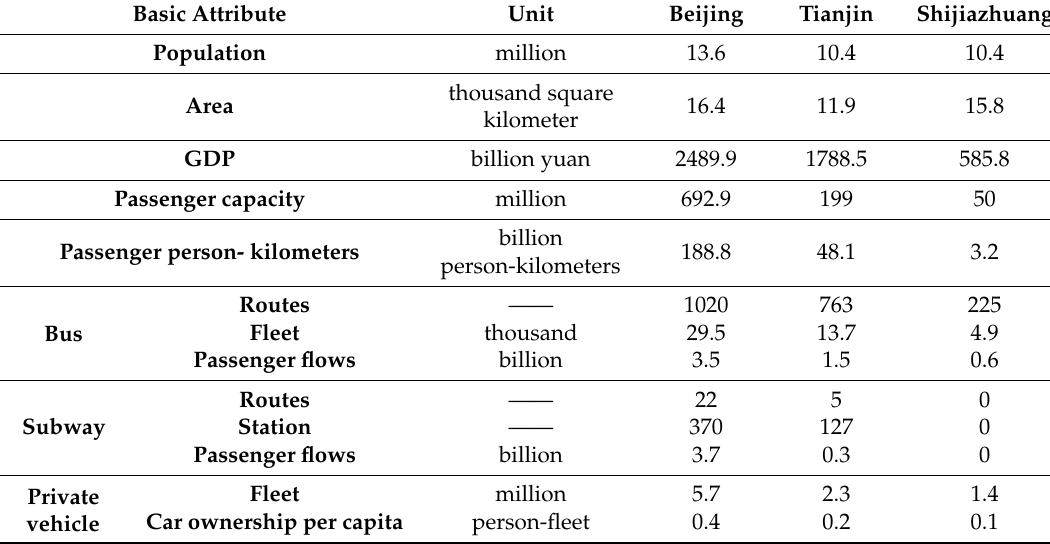
Table 1. General information of BTH